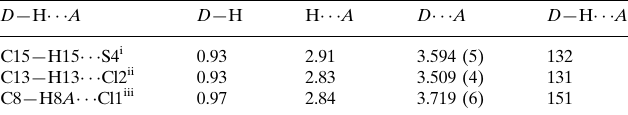
Hydrogen-bond geometry (A˚ , (cid:2)